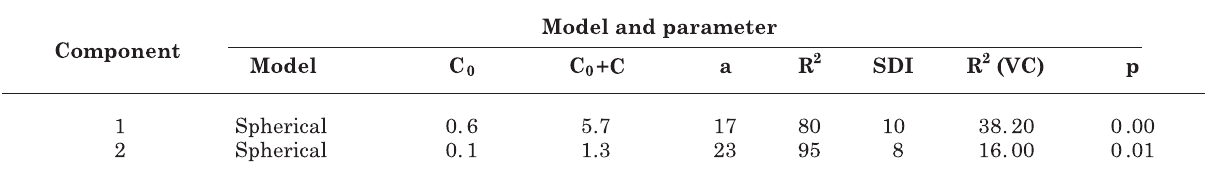
table 3. Models and parameters of the variograms adjusted for the two principal components